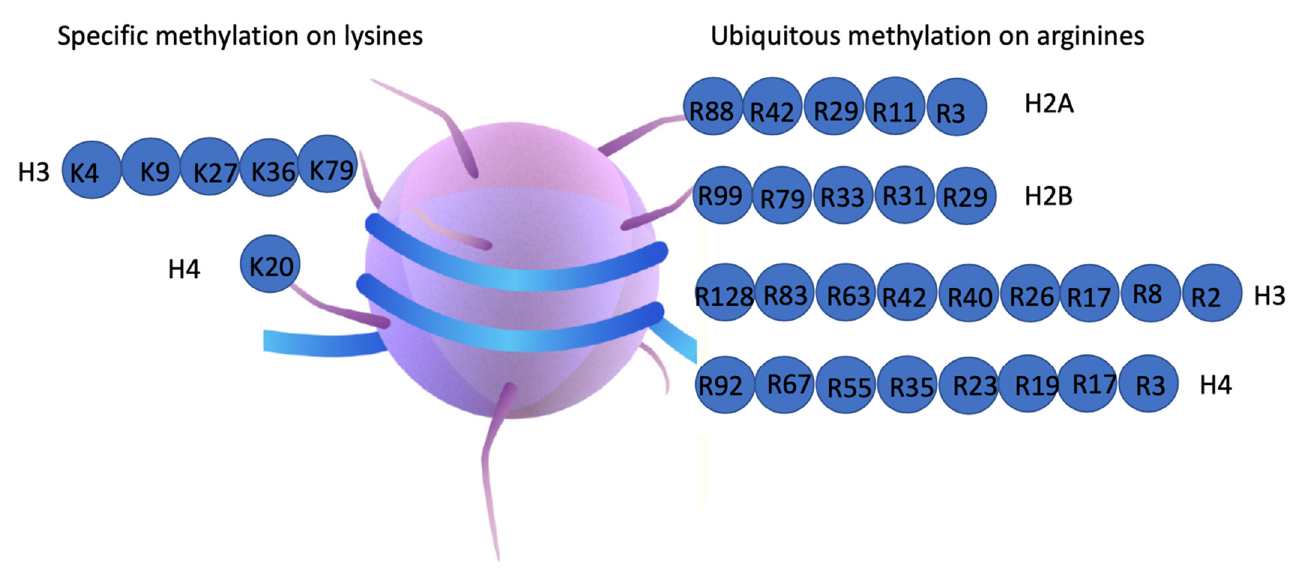
Figure 1. Possible histone methylation. Histone lysine methylation is very specific and limited while histone arginine methylation seems not specific and ubiquitous.